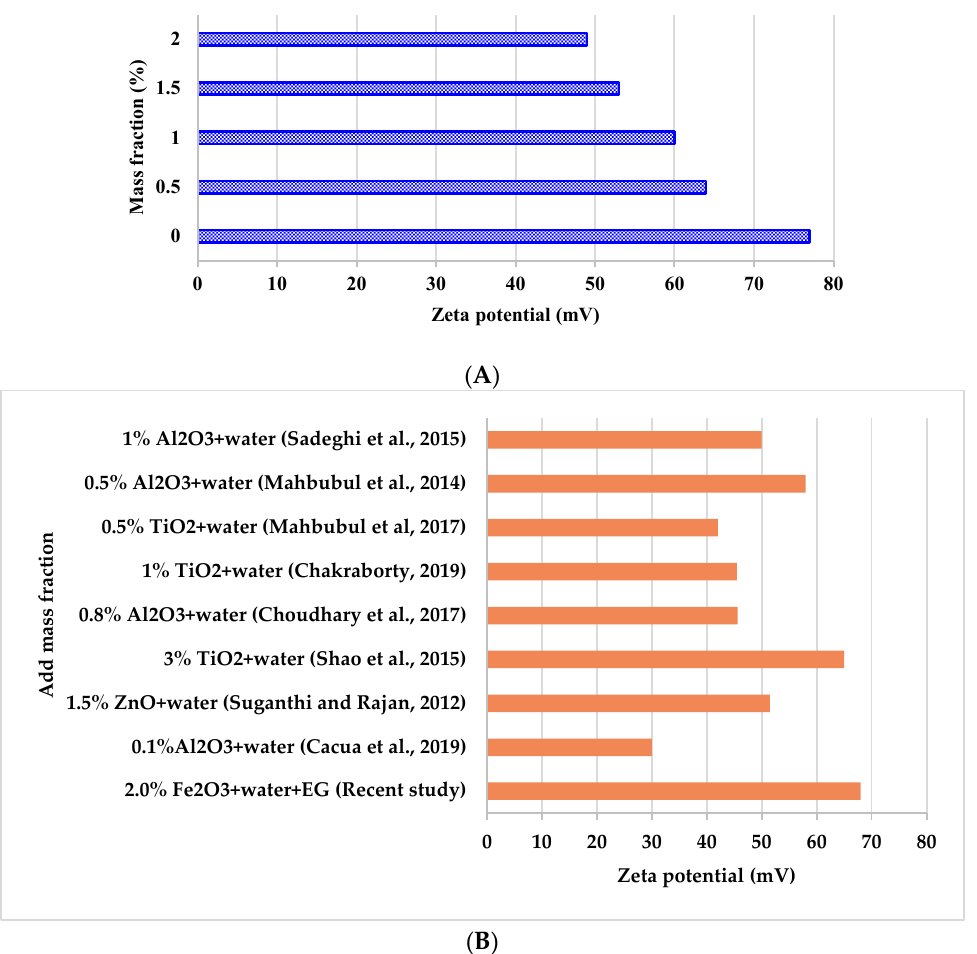
Figure 6. The effect of mass fraction added on resulted nanofluid stability ( A ), and a comparison between recent study stability and others from literature ( B ).